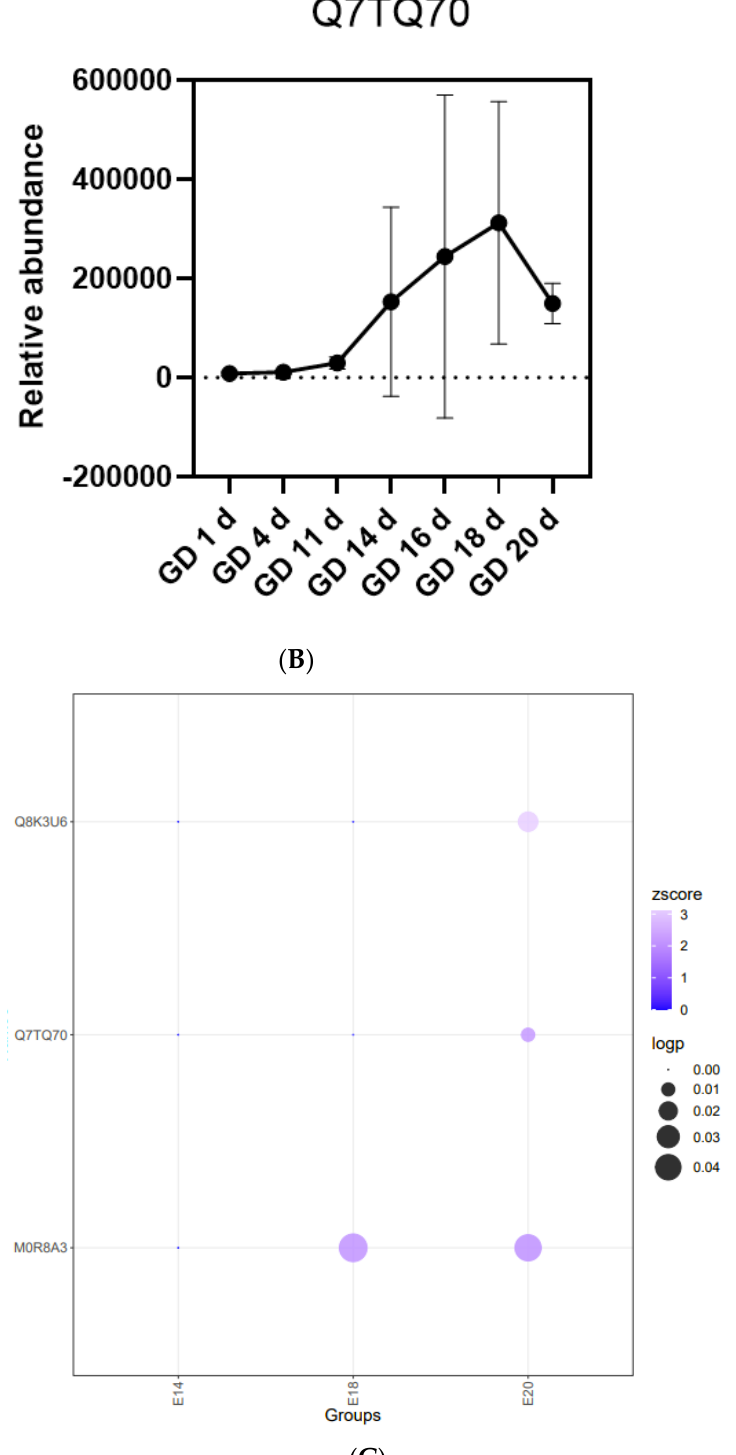
Figure 9. The urinary proteome exhibited coagulation-related changes before labor. ( A ) The line plot for the relative abundance of coagulation-related protein MOR8A3 during pregnancy. ( B ) The line plot for the relative abundance of coagulation-related protein Q7TQ70 during pregnancy. Each group (time point) was involved in three experimental replicates. Relative protein expression levels at each time point were assigned the mean ± SD value. ( C ) Coagulation-related proteins MOR8A3, Q7TQ70, and Q8K3U6 on GD 14 d, GD 16 d, and GD 20 d.